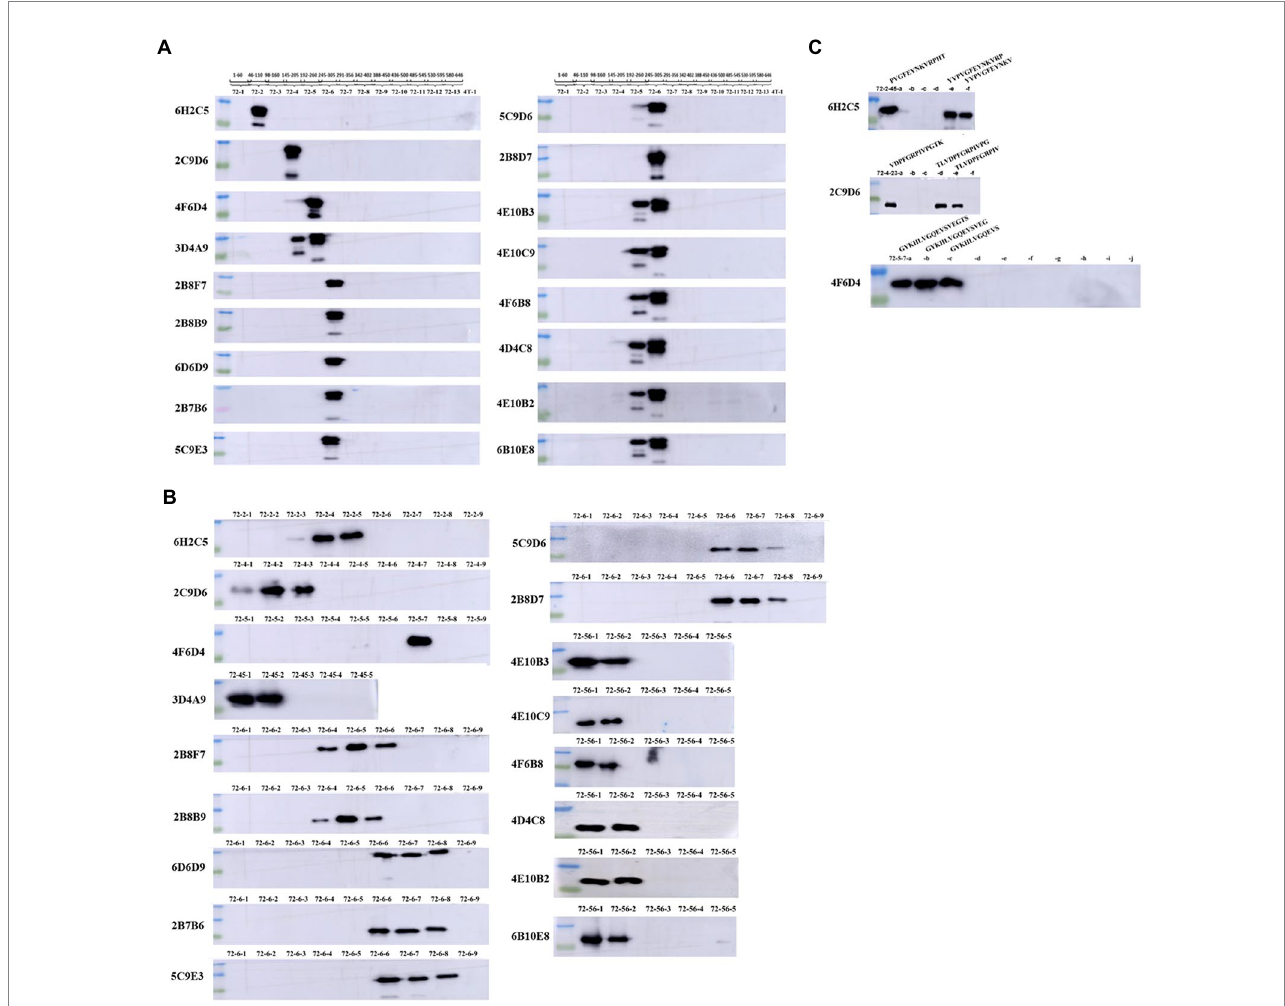
FIGURE 5 Chromatograms of 17 mAbs recognition epitopes. (A) The reactivity of 13 overlapping peptides (p72-1–p72-13) truncated based on full-length p72 with 17 mAbs. (B) The reactivity of truncated overlapping peptides based on six peptide fragments (p72-2, p72-4, p72-5, p72-45, p72-6 and p72-56, which have reactivities identified in A ) with 17 mAbs. (C) To further define the epitopes identified by the 3 mAbs (6H2C5, 2C9D6, and 4F6D4), the N- or C-terminus of the peptide fragments (72–2-45, 72–4-23, 72–5-7) were sequentially subtracted by 2 or 3 amino acids and reacted with these 3